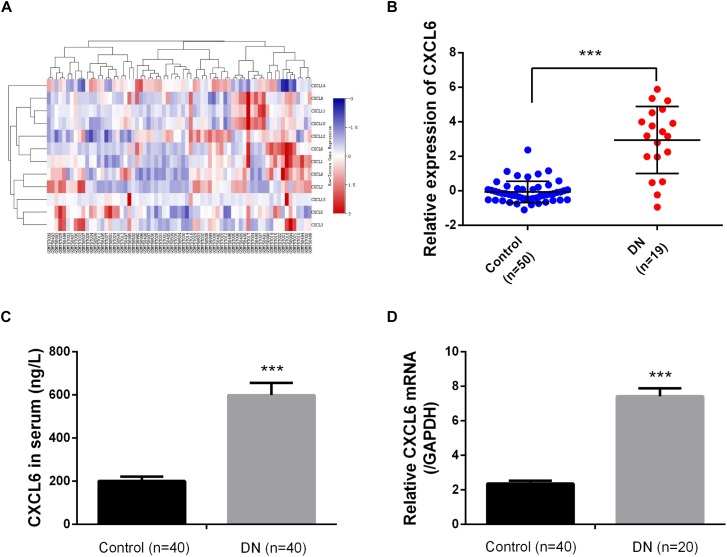
Expression of CXCL6 was upregulated in DN patients. (A) CXCL mRNA expression file of 19 human DN kidney samples and 50 healthy kidney tissue were performed based on GEO DataSets (Asscess ID: GSE30122). (B) The expression level of CXCL6 in human DN kidney samples (n = 19) and healthy kidney tissue (n = 50) (∗∗∗P < 0.001). (C) The Serum levels of CXCL6 in normal (n = 40) and DN patients (n = 40) with kidney interstitial fibrosis were determined using Elisa. (D) CXCL6 mRNA levels detected in 20 human DN kidney samples and 40 healthy kidney tissues using qRT-PCR. ∗∗∗P < 0.001.